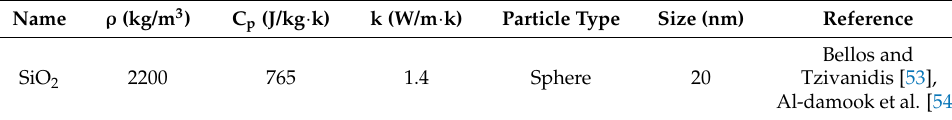
Table 4. Thermal properties of the nanoparticles considered in the present work.